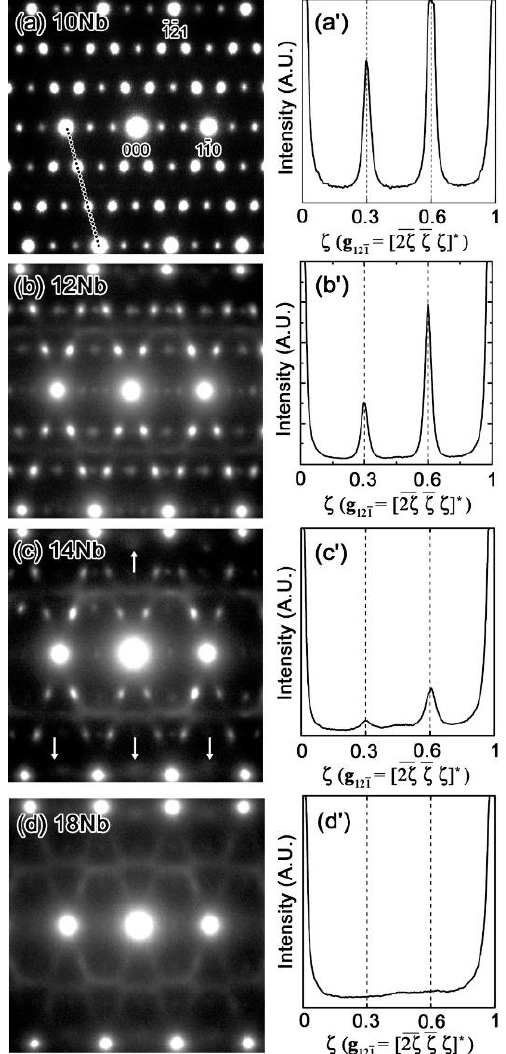
Figure 3. Results for Zr- x at.% Nb alloys (10 ≤ x ≤ 18), as obtained by applying the incident beam in the [113] direction at room temperature: ( a – d ) diffraction patterns for x = 10, 12, 14, and 18, respectively; ( a’ – d’ ) corresponding intensity profiles.